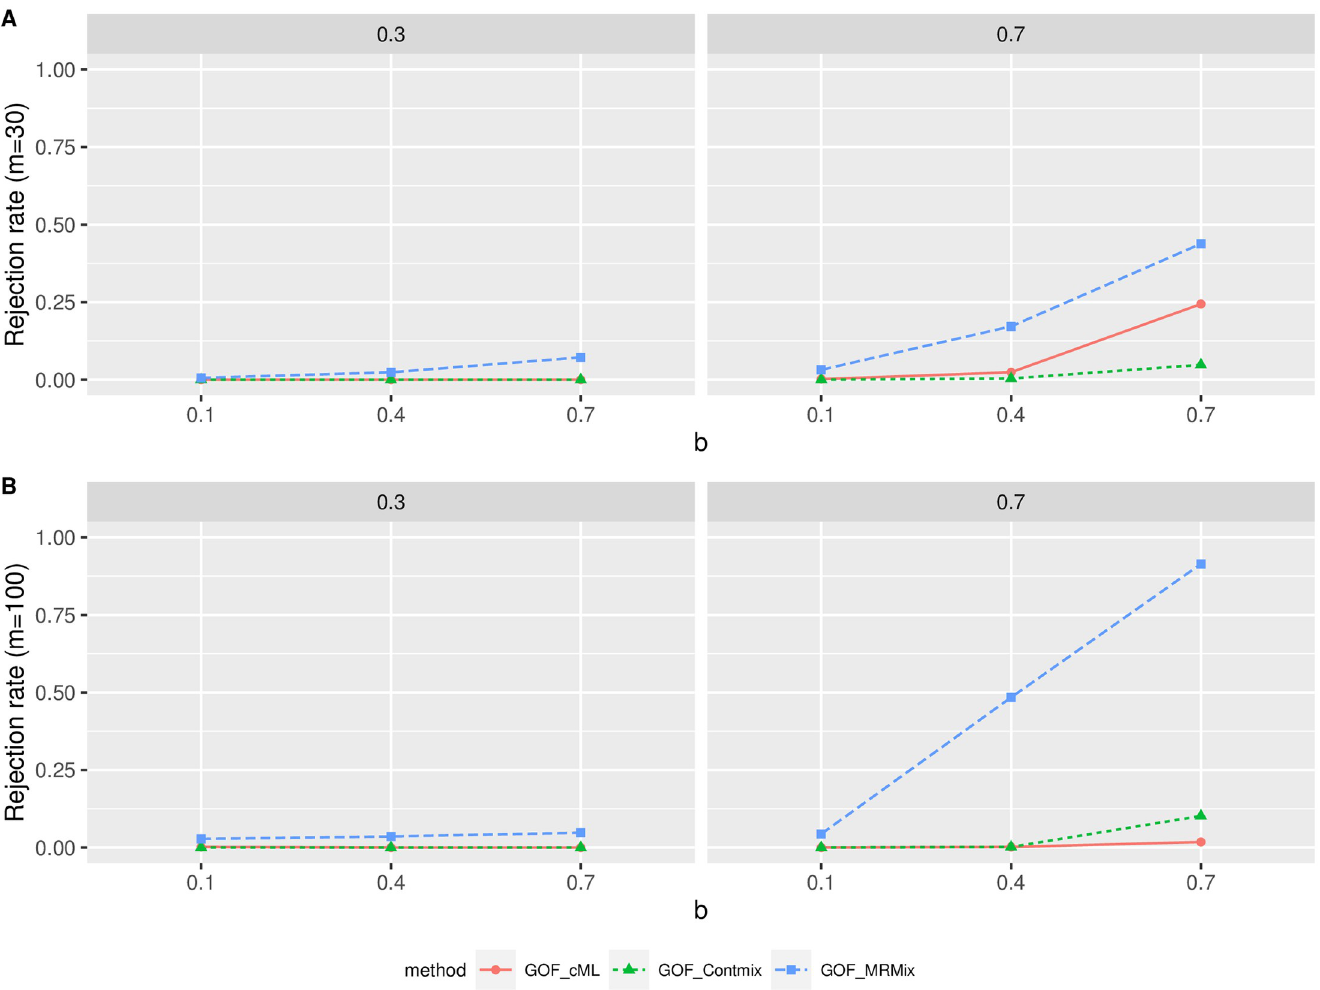
Fig 8. Simulation results for GOF testing with directional pleiotropy and InSIDE violated (while the plurality assumption for other three methods holding). θ = 0.2 and n = 50 000. The y-axis gives the rejection rate that the results from two methods were consistent, while the x-axis gives the increasing degree of InSIDE being violated. A: m = 30. B: m = 100. The two columns correspond to 30% and 70% invalid IVs respectively.